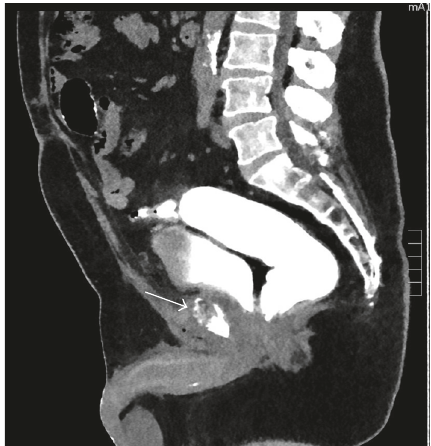
Figure 3: CT sagittal view of the abdomen and pelvis after admin- istration of rectal enema, following the retrograde urethrogram. No evidence of contrast leakage from the bladder, urethra, or rectum is seen. No air bubbles are seen in the retropubic area in the location of the suture material that was reported on the previous MRI, confirming that the appearance on the MRI was related to surgical sutures, rather than leak. The bony abnormality in the symphysis pubis is also demonstrated in the view